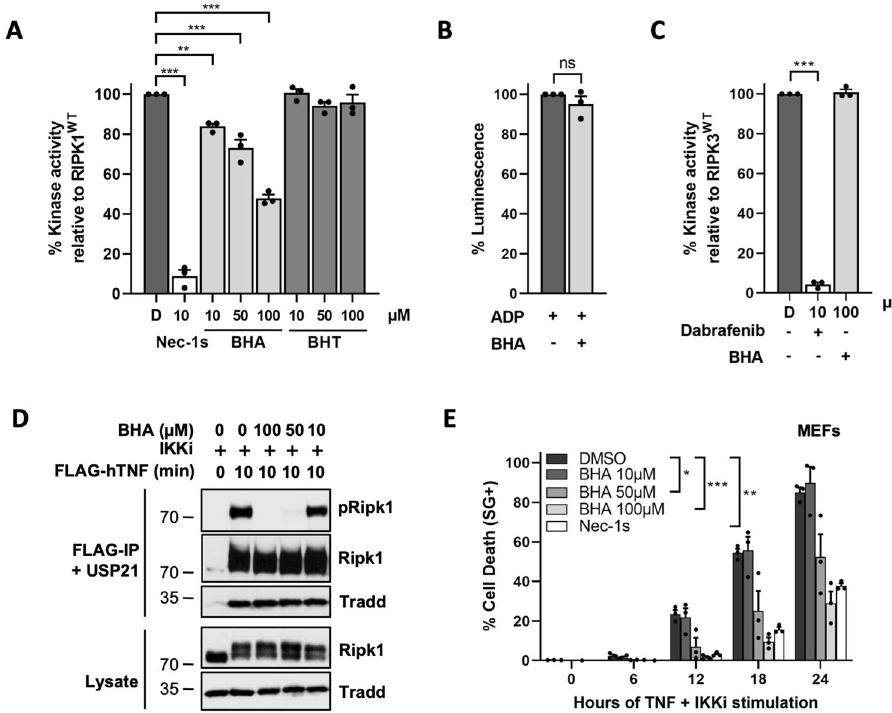
Fig. 4 BHA acts as a direct RIPK1 kinase inhibitor. A , C Quantitative RIPK1 (AA 1 – 479) ( A ) or Ripk3 (AA 1 – 439) ( C ) enzymatic activities were measured by ATP consumption using ADP-Glo kinase assays. The compounds were used at indicated concentrations and ‘ D ’ is short for DMSO. B The ADP-Glo reaction was performed in the absence of active kinase to assess the possible interference of BHA (100 µM) with the luminescence reaction. Results are presented as a percentage relative to the activity of the RIPK1/3 in absence of inhibitors ( A , C ), or as a percentage relative to the ADP-Glo luminescence reaction ( B ) and are the mean ± SEM of three independent kinase assays ( n = 3). Statistical signi fi cance was determined by one-way ANOVA followed by a Tukey post hoc test ( A – B ) or by a two-tailed paired t test ( C ). D MEFs were pretreated for 30 min with the indicated compounds (5 µM TPCA-1) before stimulation with 1 µg/ml FLAG-hTNF for the indicated duration. TNFR1 complex I was then FLAG-immunoprecipitated and the IPs were treated with USP21 before analysis by immunoblot, where pRIPK1 refers to autophosphorylation of RIPK1 on S166/T169. The results are representative of at least two independent experiments. E MEFs were pretreated for 30 min with the indicated compounds before stimulation with 20 ng/ml hTNF for the indicated duration. Cell death was measured over time by Sytox Green (SG + ) positivity, and the results are presented as mean ± SEM of three independent experiments ( n = 3). Statistical analysis on kinetic cell death assays with more than one timepoint is detailed in the Methods section ( E ). Signi fi cance between samples is indicated in the fi gures as follows: * P < 0.05; ** P < 0.01; *** P < 0.001; NS, not signi fi